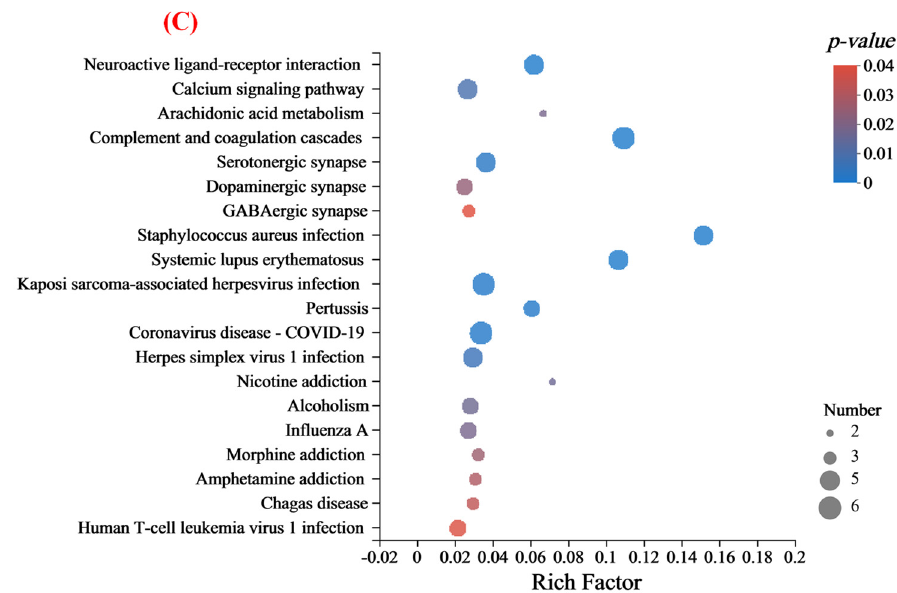
Figure 5. ( A ) Statistical distribution plot of differential expressed proteins in GO level 2 classification; ( B ) subcellular structural localization analysis of differential expressed proteins; and ( C ) KEGG bubble chart of differentially expressed proteins. Table 2. Results of KEGG enrichment analysis of differentially expressed proteins in hippocampus.